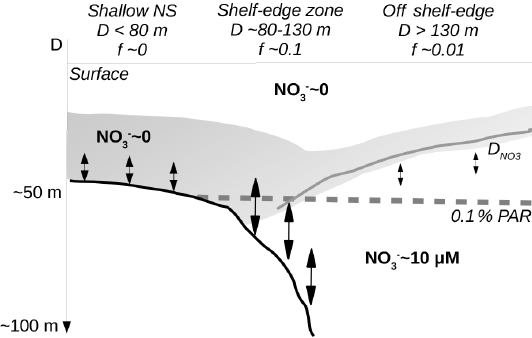
Figure 9. Sketch of conditions across the shelf-edge zone during summer. The largest f ratios are found above the shelf-edge zone ) comes into contact with increased mix- where the nutricline ( D NO 3 ing near the bottom. Deep waters are characterized by high nitrate concentration whereas surface water and water above the shallow North Sea (NS) are nitrate